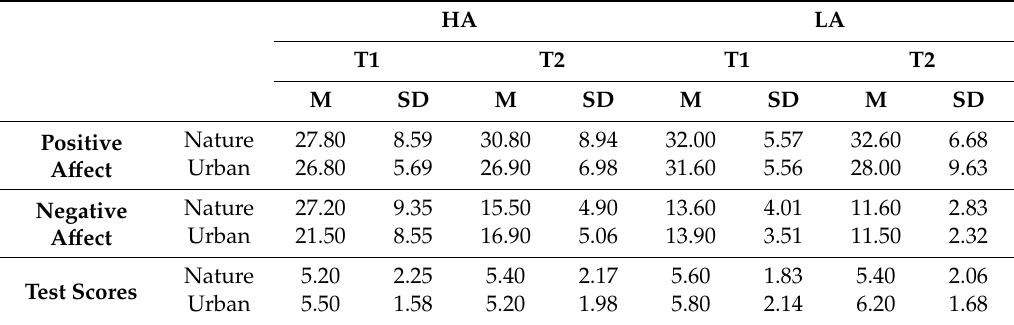
Table 1. Means and Standard Deviations for Positive A ff ect, Negative A ff ect and Test